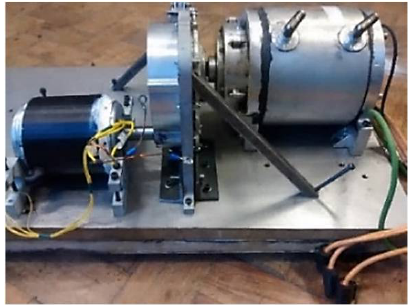
Figure 6. 20 kW IPMSM with FeSi core in experimental setup [11].